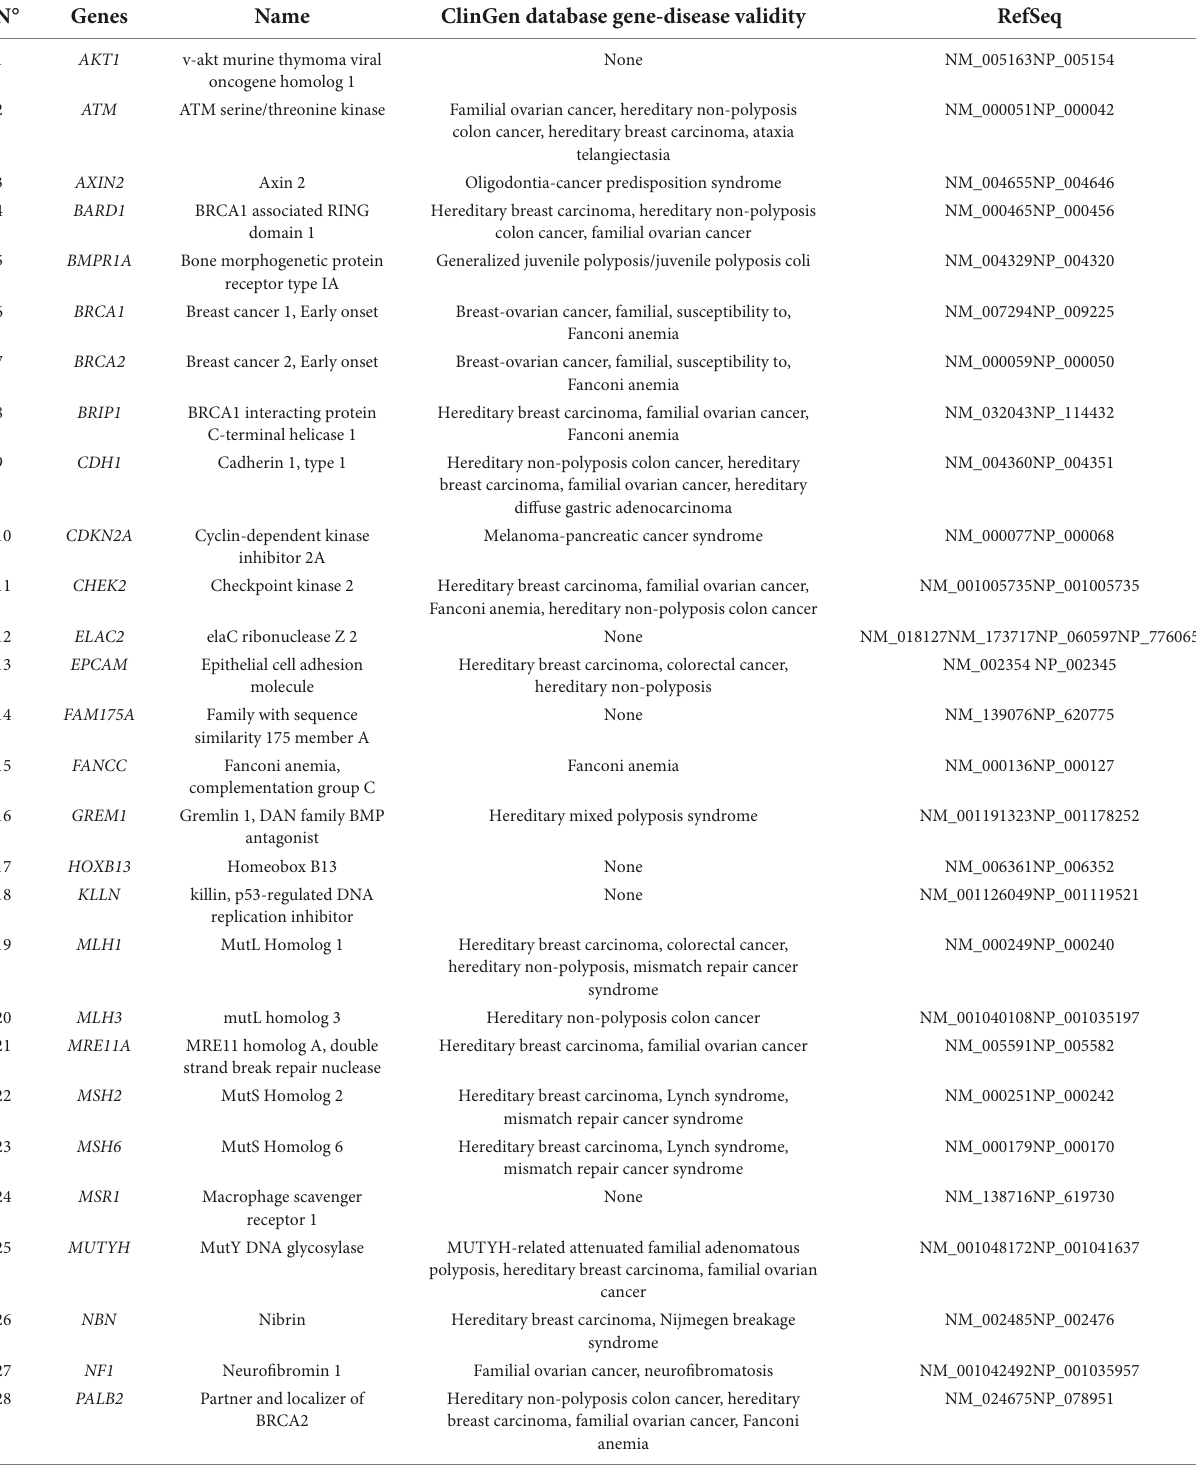
Genes included in the panel ( n =